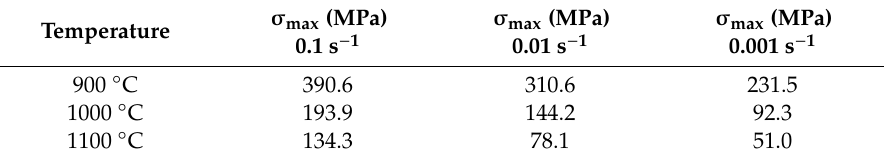
Figure 3. True stress-strain curves of the (CoCrNi) 94 Ti 3 Al 3 alloy hot-compressed at ( a ) 900 °C, ( b ) 1000 °C, and ( c ) 1100 °C. The strain rate is 0.1, 0.01, and 0.001 s − 1 .